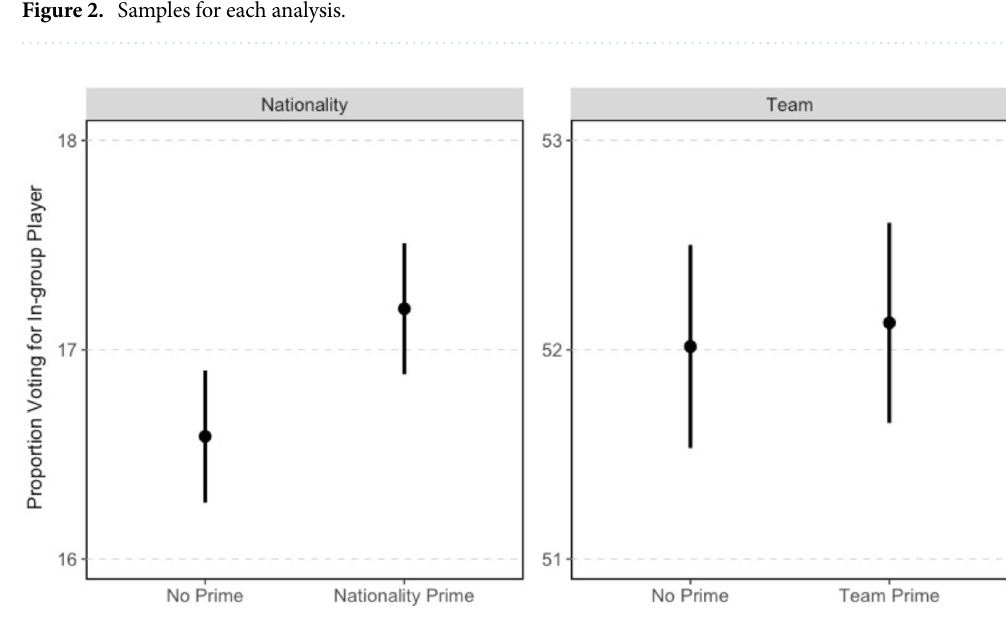
Figure 3. Effect of in-group